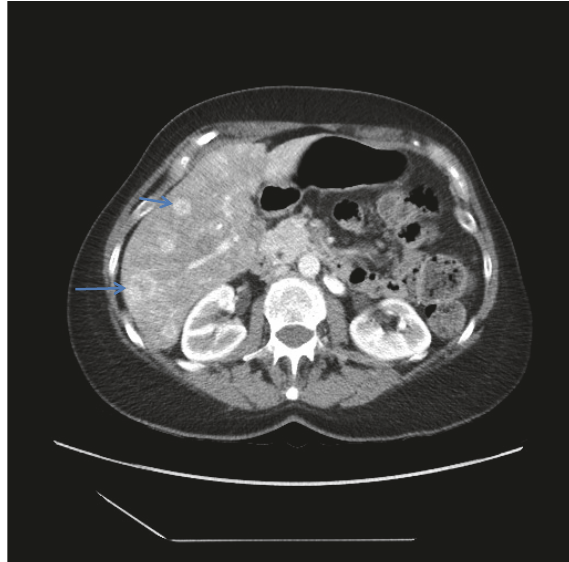
Figure 1: Computed tomography image showing multifocal hepatic lesions with peripheral enhancement and central hypoattenuation. Blue arrows point to